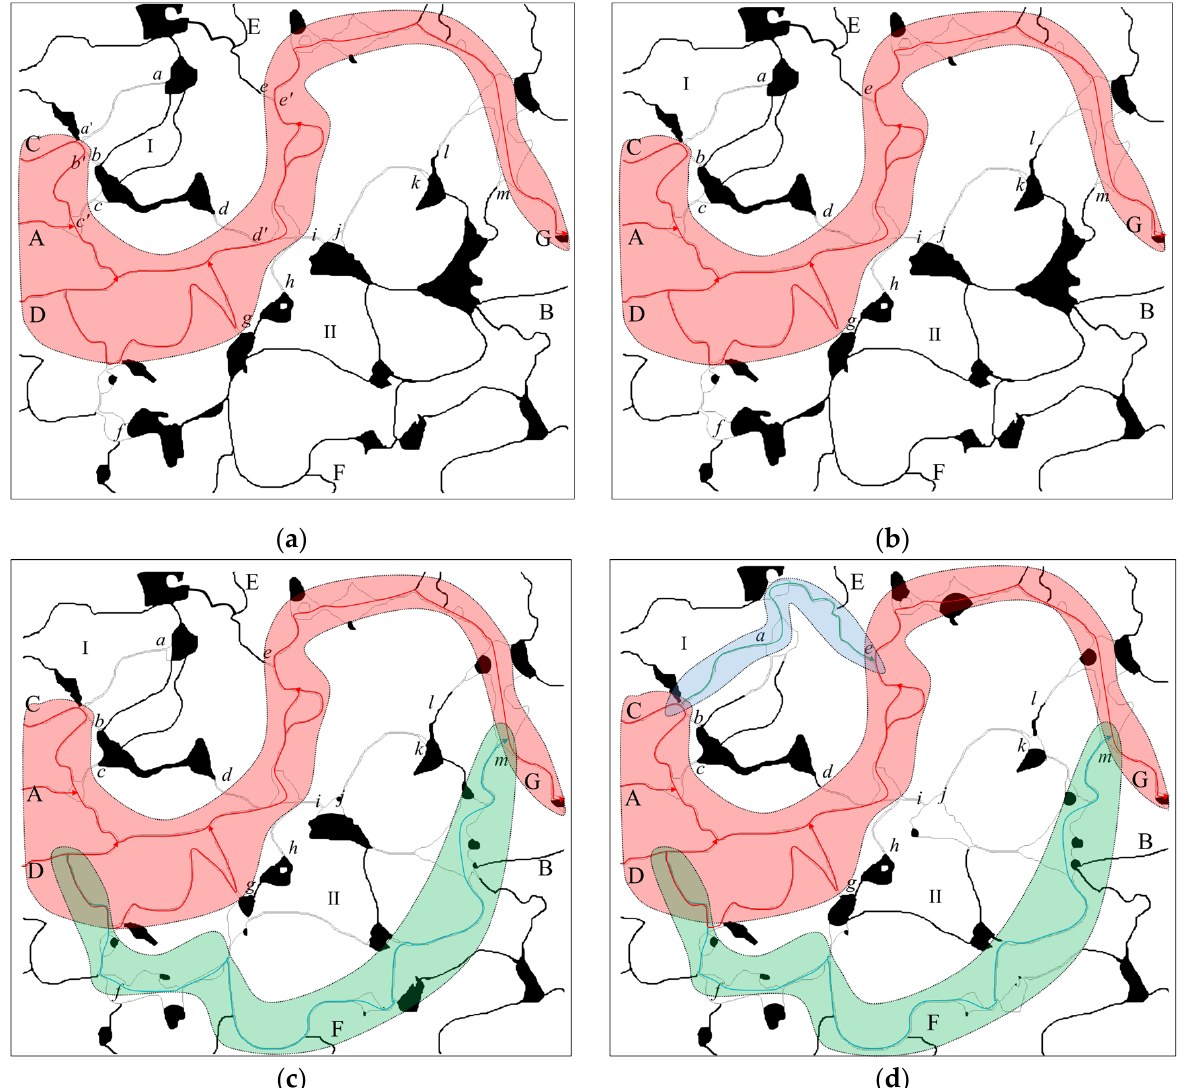
Figure 22. Final residual oil distribution and flow path characteristics after increasing the water injection rate: ( a ) residual oil after water flooding, at an injection velocity of 0.005 m · s − 1 ; ( b ) final residual oil at injection velocity of 0.01 m · s − 1 based on the results at a velocity of 0.005 m · s − 1 ; ( c ) final residual oil at an injection velocity of 0.015 m · s − 1 based on the results at a velocity of 0.005 m · s − 1 ; ( d ) final residual oil at injection velocity of 0.02 m · s − 1 based on the results at a velocity of 0.005 m · s − 1 . Different positions are indicated by lower case